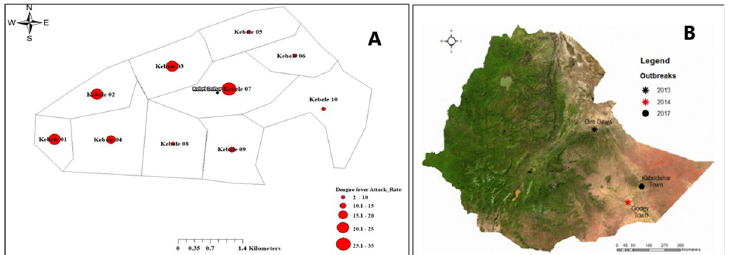
Fig 2. Distribution of Dengue Fever. (A) Attack Rate (Cases per 10,000 population) by Village–Kabridahar Town (Villages 1–10), Kabridahar District, Korahay Zone, Somali region, Ethiopia, 2017. (B) Important Dengue Fever outbreak locations since first detected in Ethiopia in 2013. ( Basemap obtained from https : //www . worldofmaps . net/en/ africa/map-ethiopia/satellite-map-ethiopia . htm and is compatible with CC BY licensing ).